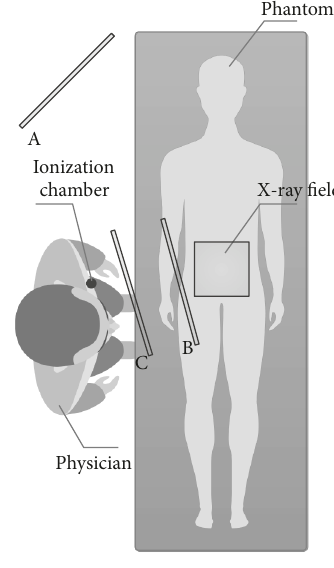
Figure 4: Different positions of the ceiling-mounted shielding for